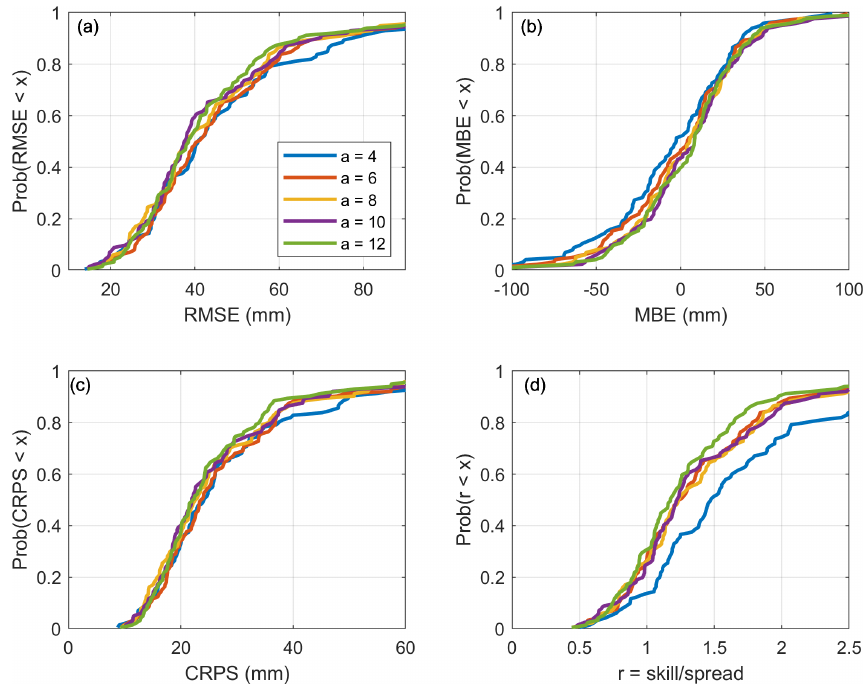
Figure 9. Cumulative distributions of the scores for the validation sites when assimilating SR50 data, according to the applied uncertainty